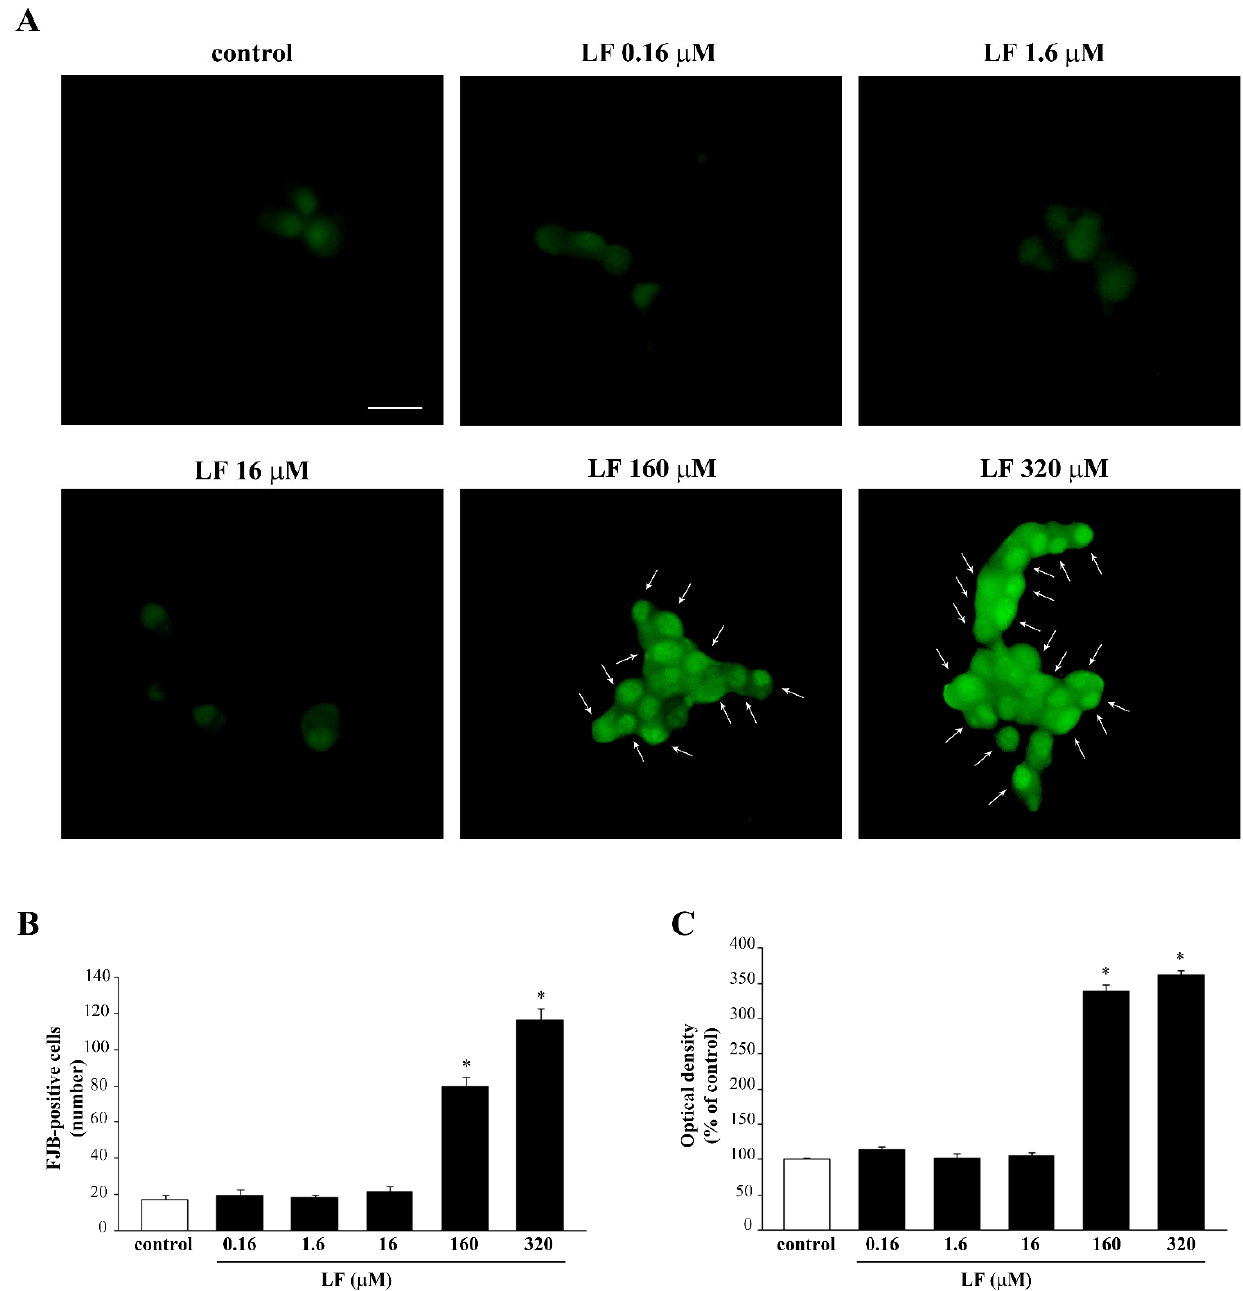
Figure 2. Dose–response of LF on FJB staining. ( A ) Representative pictures of FJB-stained PC12 cells after treatment with various doses (from 0.16 µ M up to 320 µ M) of LF for 72 h. The number and intensity of FJB fluorescent cells is reported in graphs ( B , C ), respectively. Arrows indicate FJB intensely positive cells. * p < 0.05 compared with control. Scale bar = 17 μ M.